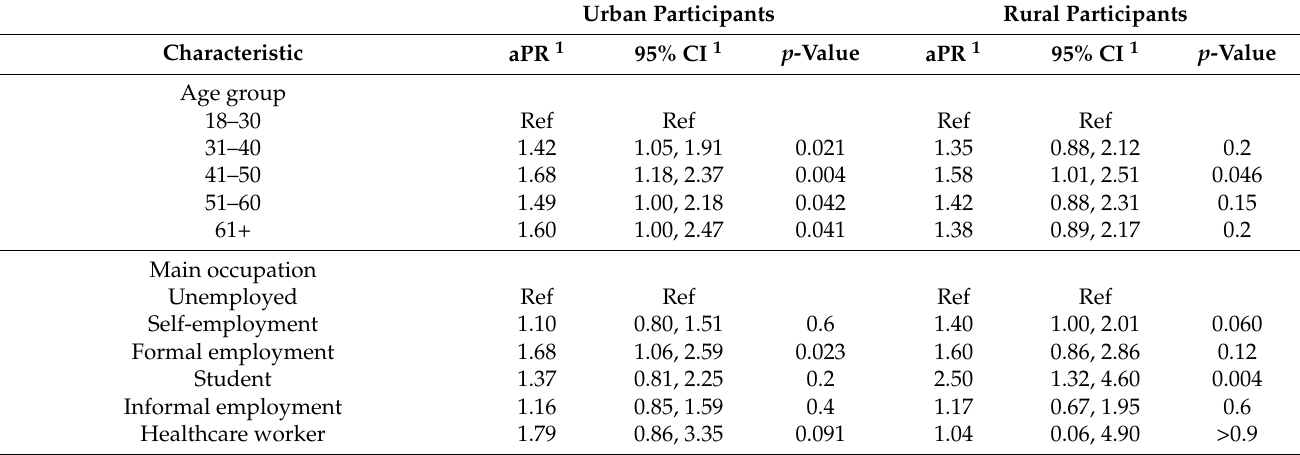
Table 3. Factors associated with COVID-19 vaccine uptake among the urban and rural study participants. Urban Participants Rural